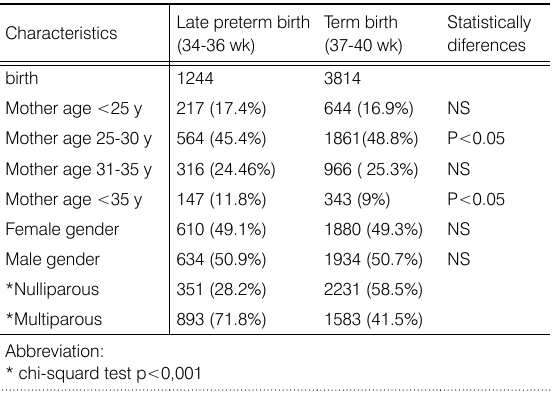
Table 1. Demographic characteristics